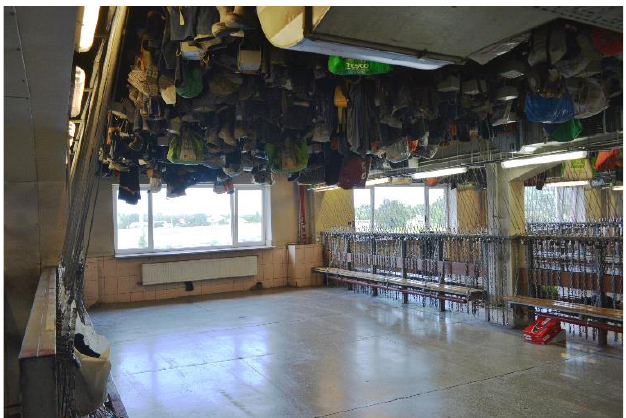
Figure 2. A guildhall in LW Bogdanka S.A. Source: photo provided by LWB. The sanitation and hygiene facilities, which include chain baths and showers, can be the most challenging (Figure 3). Before descending, workers leave clean clothes on the clean side of the chain bath and walk to the other side, where each worker has their own hook with work clothes. This system of hanging up clothes allows all clothes to dry well after finishing work. However, the nature of the bathhouse during the epidemic posed a serious risk. Mainly because of the very high accumulation of workers in the bathhouse compartments. The distribution of workers in the bathhouse is not orderly in terms of ward and work areas. Workers from the surface, longwall, face and workshop departments may meet in the same compartment. If an infection was detected in any of them, there was a high probability that the rest of the workers were also infected.